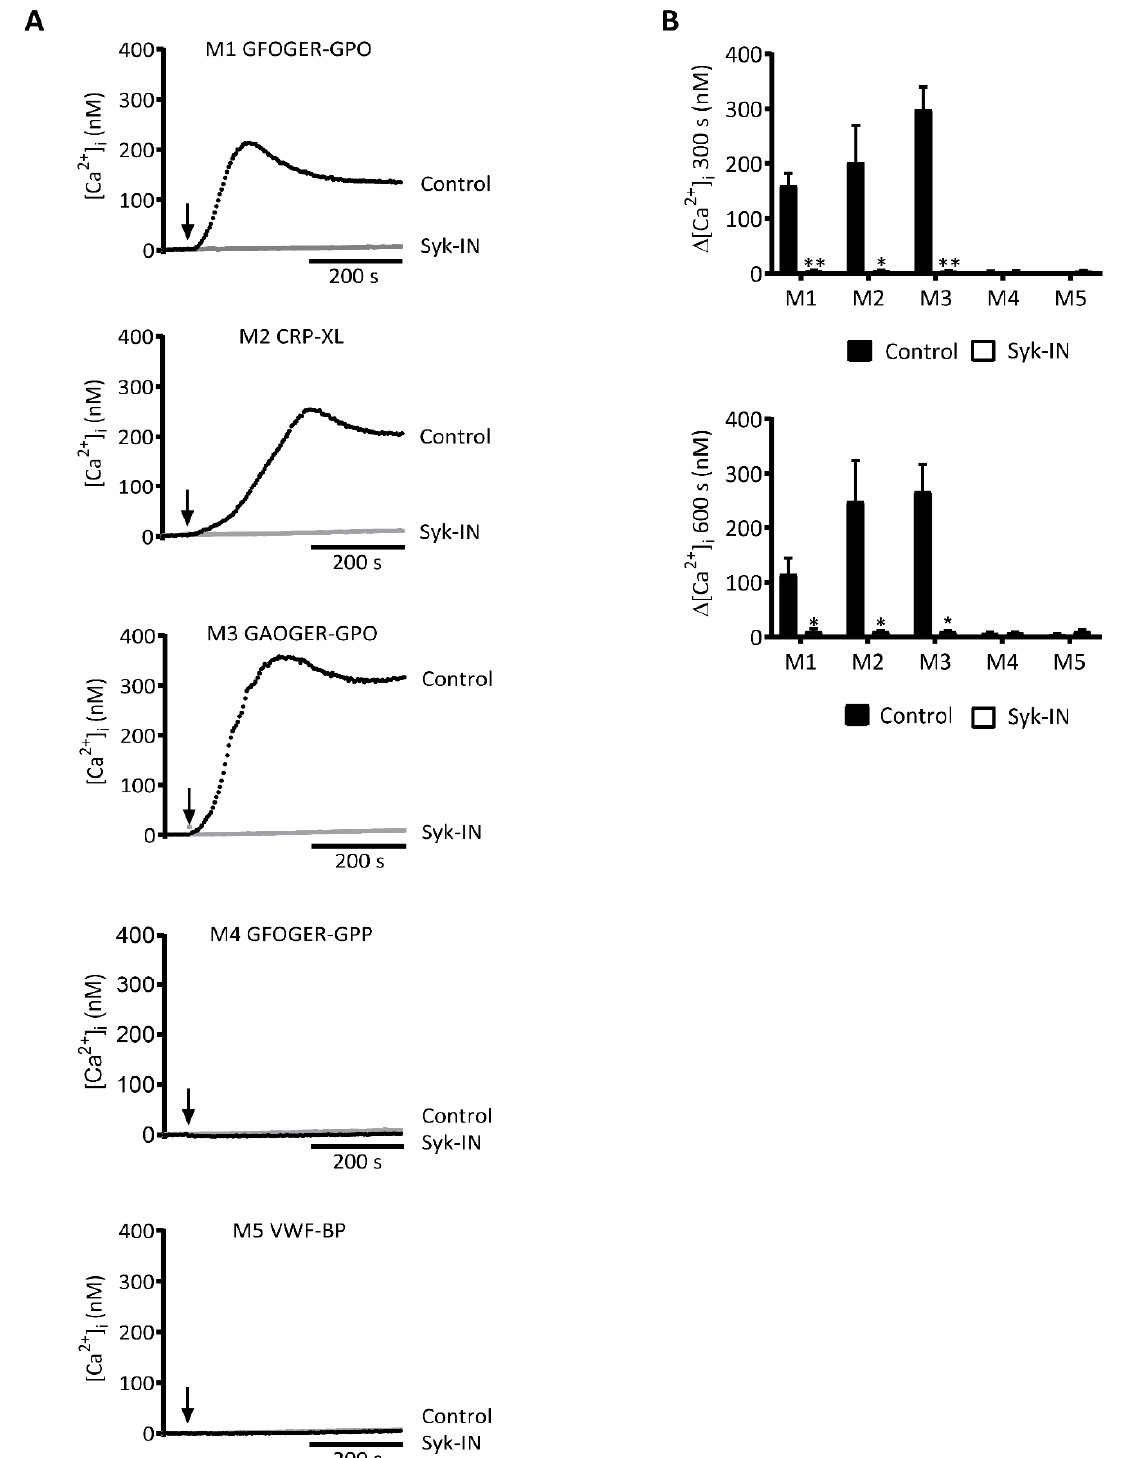
Figure 1. Syk inhibition a ff ecting platelet Ca 2 + rises by collagen peptides with (GPO) n motif. Fura-2-loaded platelets in 96-well plates were pre-incubated with Syk-IN (5 µ M) or left untreated before stimulation with collagen peptide (M1-5, 10 µ g / mL). Changes in [Ca 2 + ] i were recorded over time per well-plate row by ratio fluorometry using a FlexStation 3. Peptides were injected into wells at 60 s (arrow) and reached platelets in a di ff usion-limited way. ( A ) Calibrated [Ca 2 + ] i traces recorded over 600 s in the absence (black, control) or presence (gray) of a Syk inhibitor. Traces are representative of three experiments. ( B ) Quantification for M1-5 of increased [Ca 2 + ] i at 300 s (top graph) or 600 s (bottom graph). Means ± SEM ( n = 3). Paired Student’s t -tests; * p < 0.05, ** p <